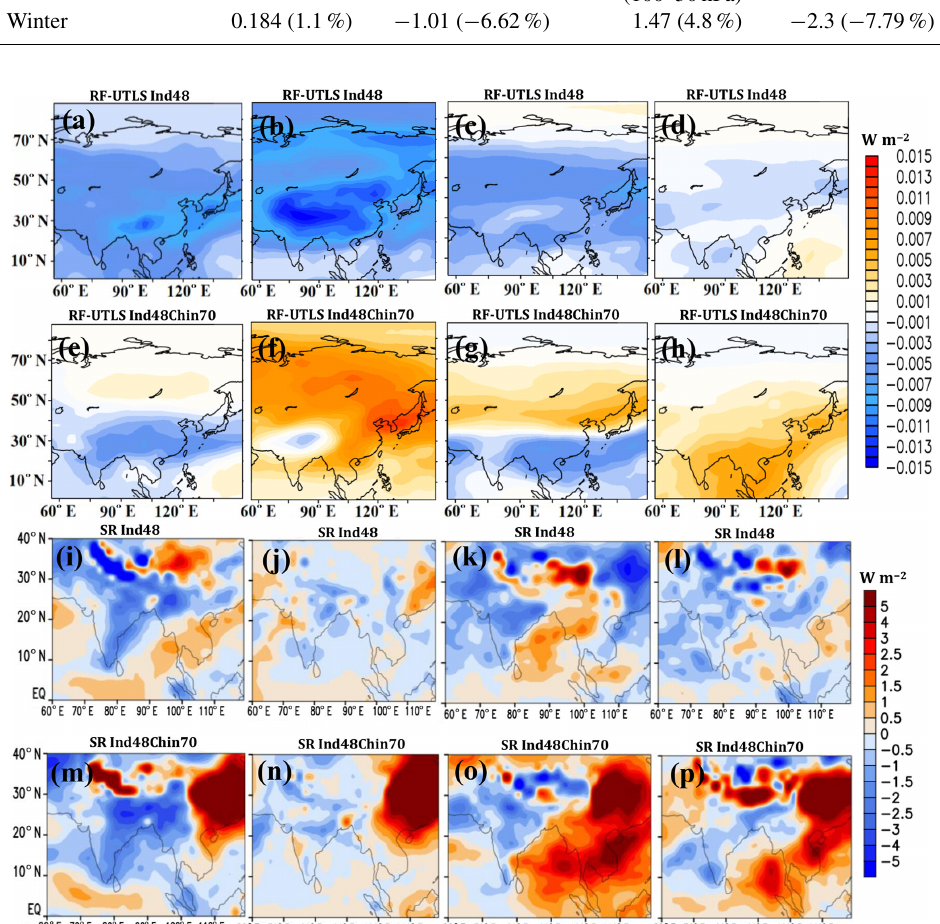
Figure 7. Simulated clear-sky direct net radiative forcing at TOA (Wm − 2 ) using the offline model due to sulfate aerosols on the UTLS– only for the (a) pre-monsoon (b) summer-monsoon, (c) post-monsoon and (d) winter seasons for Ind48; (e) – (h) same as (a) – (d) but for Ind48Chin70 simulations. The distribution of anomalies in net solar radiation (SR) (Wm − 2 ) at the surface from Ind48 for the (i) pre- monsoon (j) summer-monsoon, (k) post-monsoon and (l) winter seasons; (m) – (p) same as (i) – (l) but for Ind48Chin70